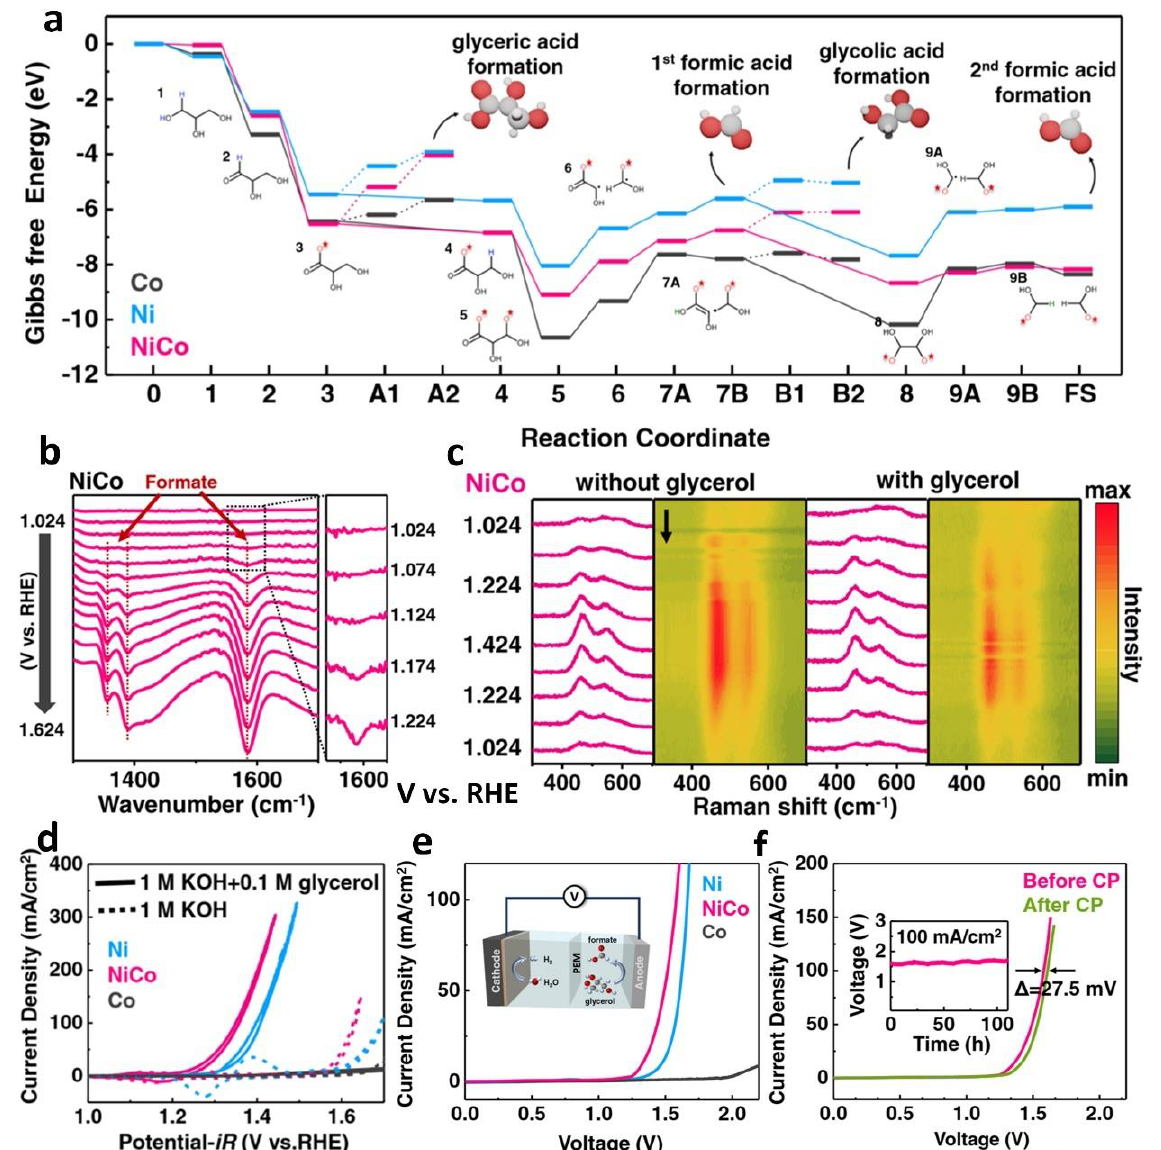
Figure 3. ( a ) The DFT − calculated Gibbs free energy profiles of glycerol oxidation reaction on Ni, NiCo and Co hydroxide. ( b ) In situ electrochemical–infrared spectra of NiCo hydroxide. ( c ) In situ electrochemical − Raman spectroscopies for NiCo hydroxide. ( d ) CV curves of Co hydroxide, NiCo and Ni with (solid line) or without (dash line) glycerol. ( e ) LSV curves for the two-electrode electrolysis coupling HER with GOR. The inset is the illustration of the electrolyzer. ( f ) LSV curves of NiCo hydroxide before and after a chronopotentiometry test performed at 100 mA cm − 2 for 110 h. The inset is the corresponding chronopotentiometry curve of NiCo hydroxide. Reproduced with permission [50], Copyright 2022, Nature Publishing Group.